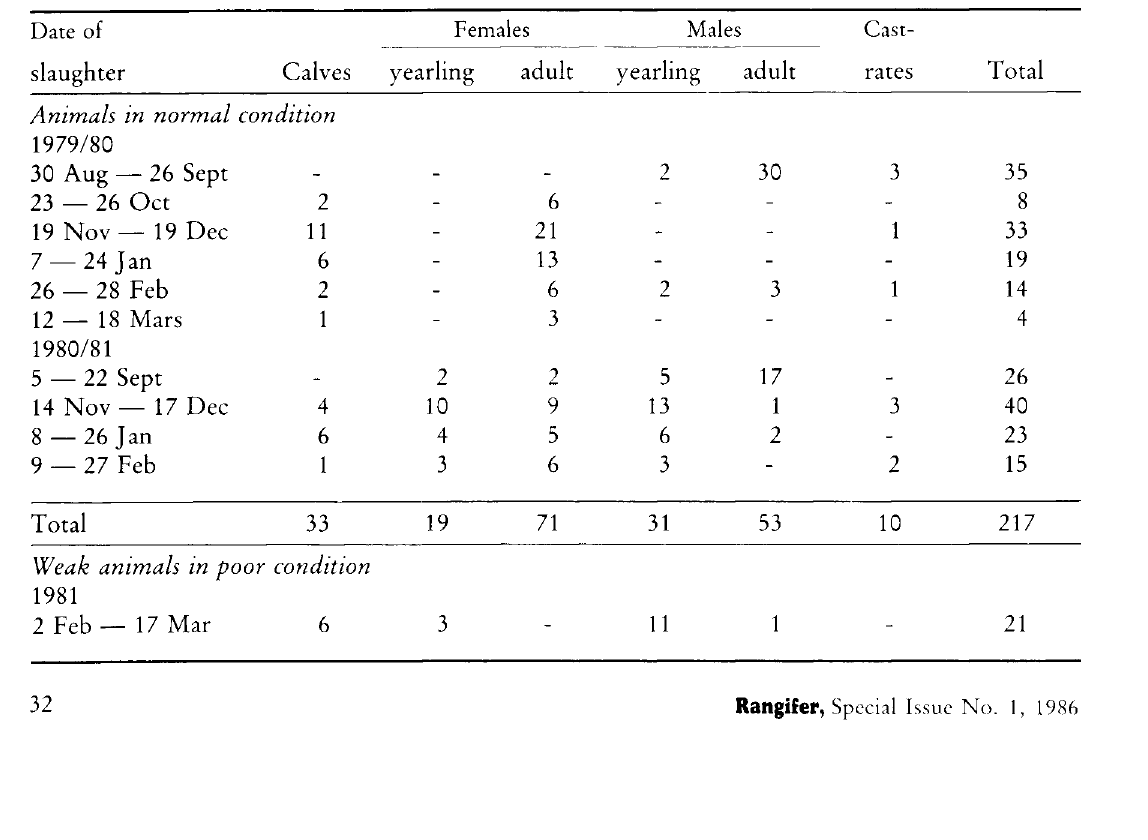
Table 2. Numbers o f animals by a^ ;e, sex and condition slaughtered at different times. Date